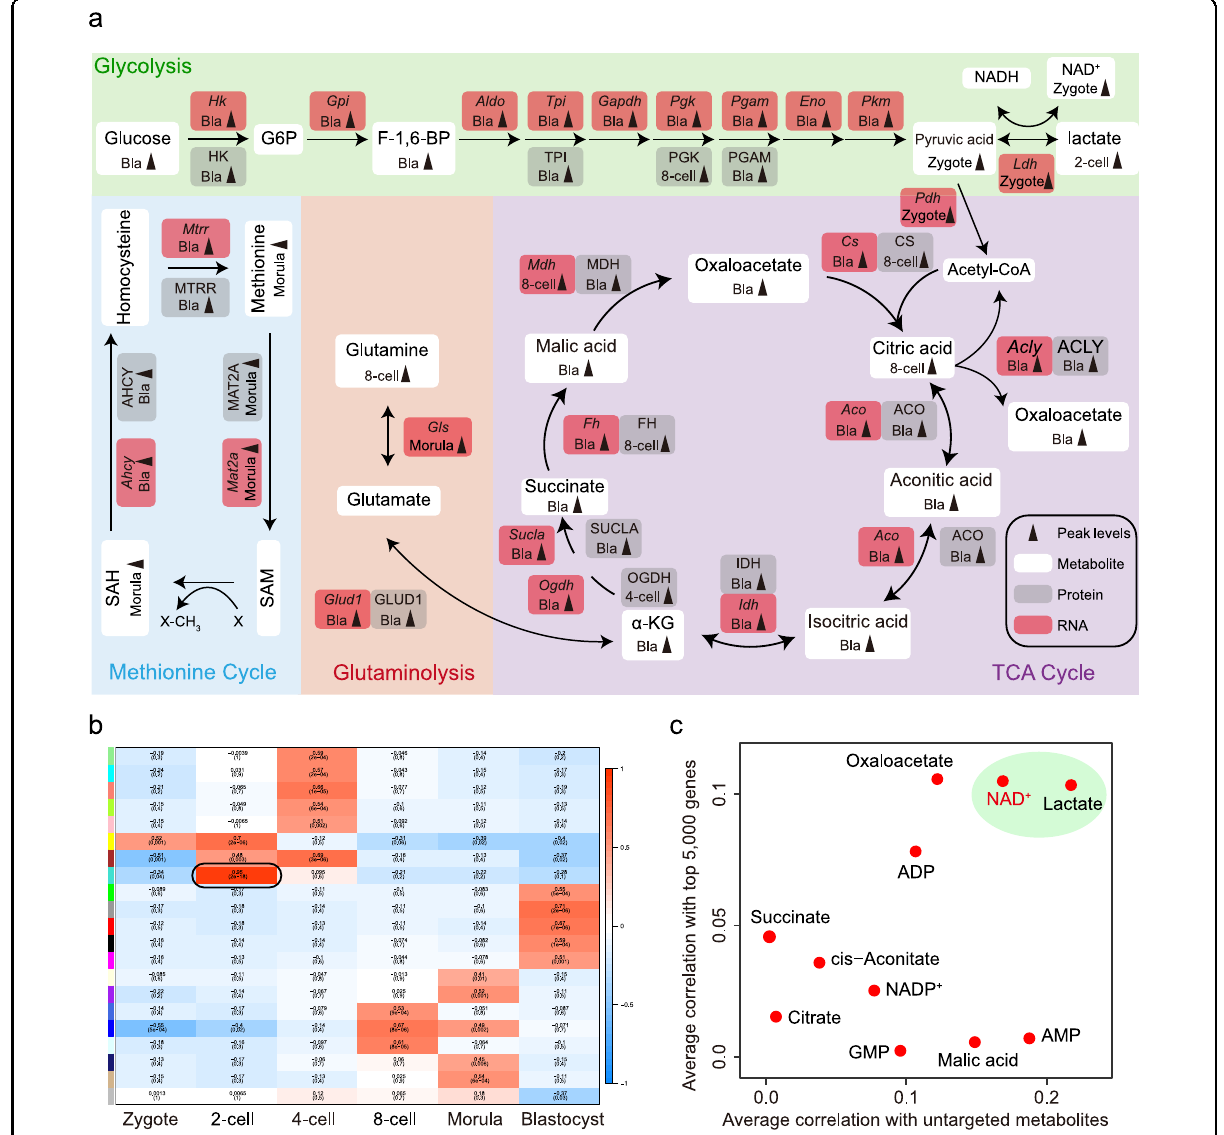
Fig. 2 Activities of metabolic pathways during mouse pre-implantation embryo development. a Schematic diagram of carbohydrate metabolism, integrated with transcriptomic and proteomic data. Gray arrows indicate peak level at indicated stage. White boxes represent metabolites, and gray and red boxes represent protein and mRNA of indicated metabolic enzymes, respectively. b Stage-speci fi c co-expression genes and metabolite modules and their correlation to development stage. Each row corresponds to a co-expression module. Numbers in each square represent correlation coef fi cients between the module and development stage, with p -values in brackets. Red and blue squares indicate positive and negative correlations, respectively; white indicates no correlation. c Correlation of metabolites and genes at the 2-cell embryo stage. The X -axis shows the correlations of a speci fi c metabolite with the top 5000 genes. The Y -axis shows the correlations of a speci fi c metabolite with other